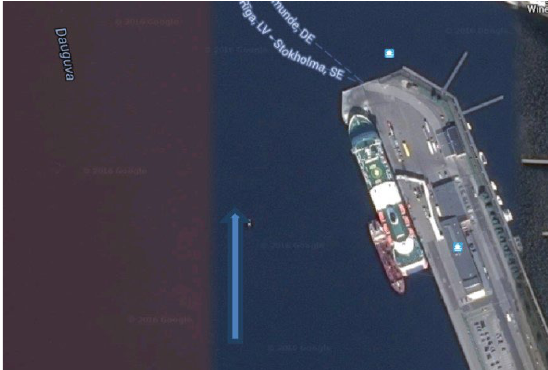
Fig. 7. A ro-ro terminal and current direction to the quay wall at the Port of